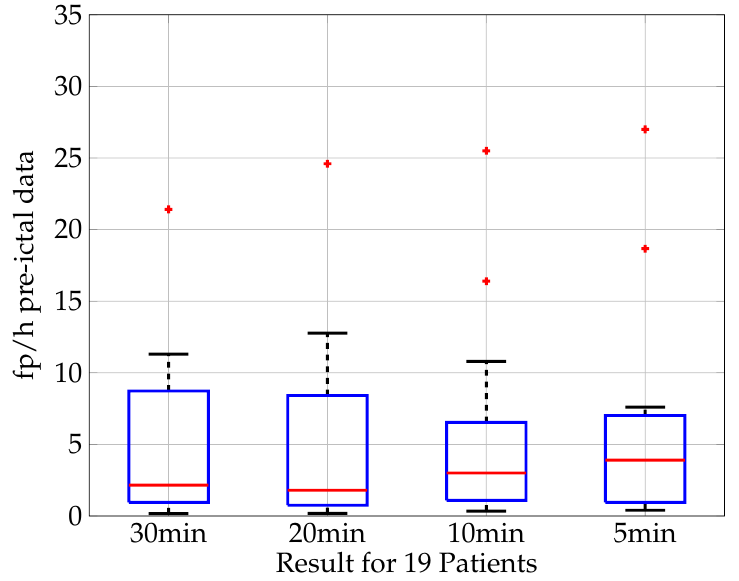
Figure 11. Seizure prediction based on pre-ictal data. Boxplot (median value (red), lower and upper quartile (blue), min. and max. value (black), outlier (red cross)) of the classification results in fp/h for 19 patients. The time period defined as ’pre-ictal’ varies from 30, 20, 10 to 5 minutes. The classification results show a median false positive rate of 2.15 fp/h for a pre-ictal time period of 30 minutes, of 1.8 fp/h for 20 minutes, 3.0 fp/h for 10 minutes and 3.9 fp/h for 5 minutes.